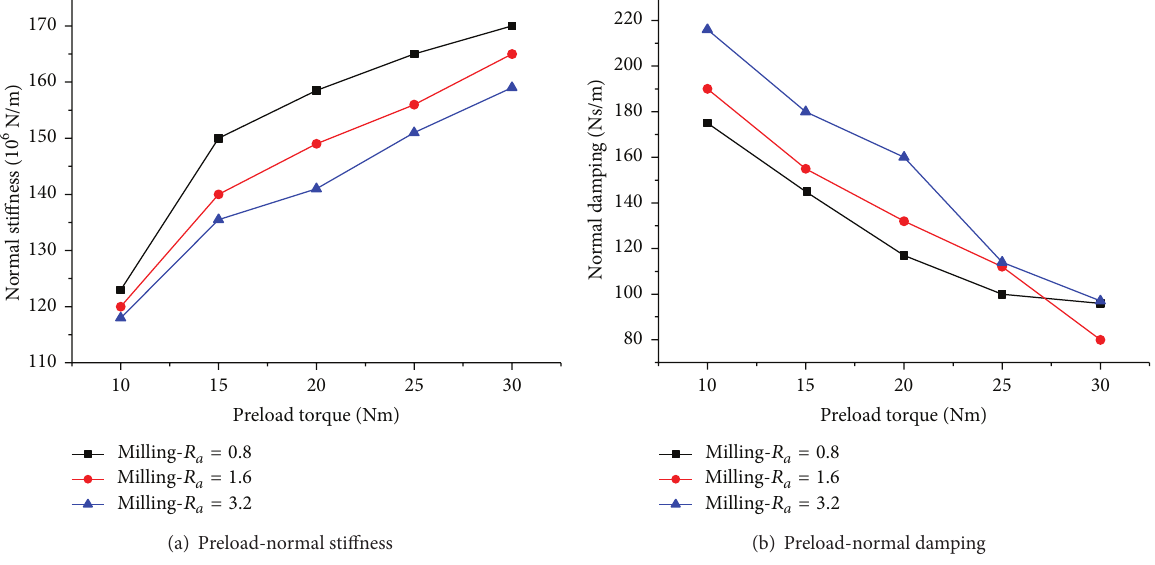
Figure 11: Comparison of dynamic characteristics in joint of different